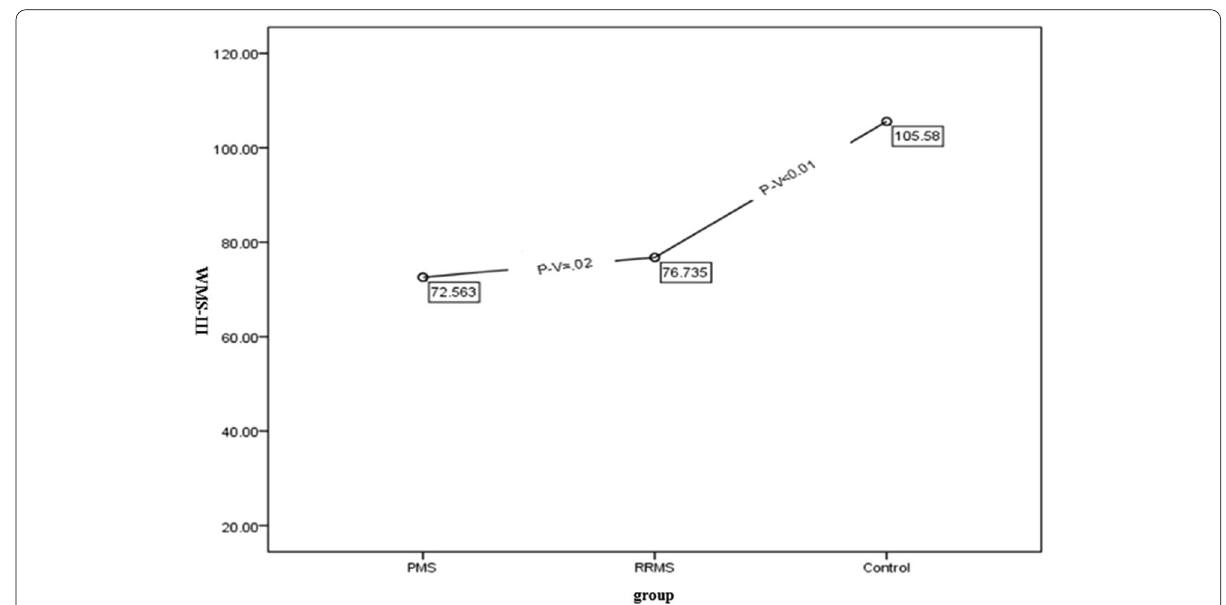
Fig. 1 Comparison of different groups in terms of WMS-III